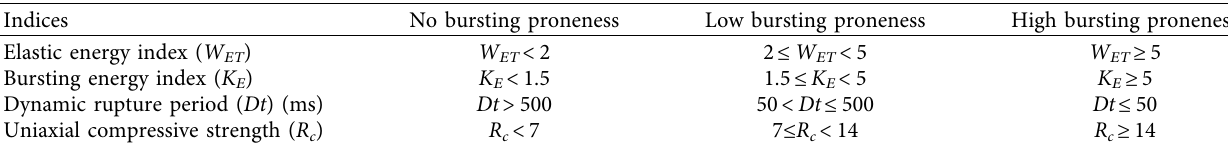
Table 1: Classification of the bursting proneness of coal and indices according to current standard in China [17]. Indices No bursting proneness Low bursting proneness High bursting proneness Elastic energy index ( W ET ) W ET < 2 2 ≤ W ET < 5 W ET ≥ 5 Bursting energy index ( K E ) K E < 1.5 1.5 ≤ K E < 5 Dt > 500 Uniaxial compressive strength ( R c ) R c <